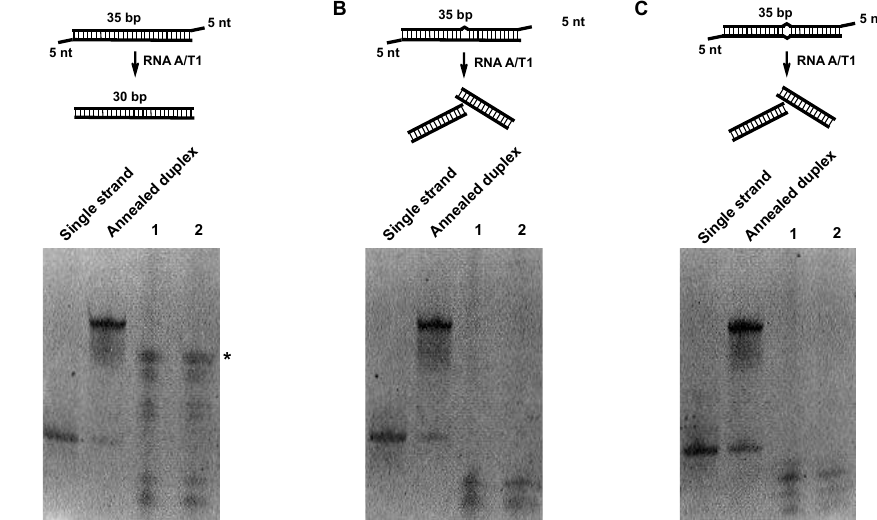
Figure 1. Digestion of RNA duplex oligos with RNAse A/T1. Initially, 1 µ g of each RNA duplex oligo was digested with different concentrations of RNAse A/T1 at 37 ◦ C for 30 min. RNA was separated on 15% acrylamide Tris/borate/ethylenediaminetetraacetic acid (TBE) native gels and stained with SYBR gold. ( A ) Digestion of perfect matched RNA duplex; * indicates an enriched RNA duplex. ( B ) Digestion of RNA duplex with bulge. ( C ) Digestion of RNA duplex with internal loop. Lane 1, 1:200 dilutions of RNAse A/T1 cocktail. Lane 2, 1:500 dilutions of RNAse A/T1 cocktail.